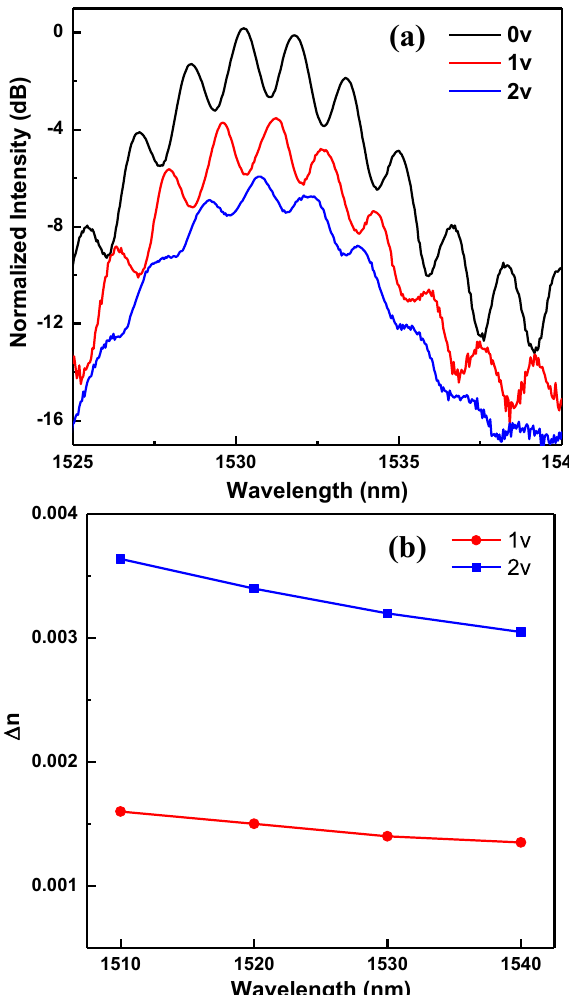
Figure 9: (a) FP interference filtering spectrum of the device waveguide under different reverse biases. (The baseline for each curve has been shifted to separate from each other). (b) Electrorefractive index variation of the device as a function of wavelength under different reverse